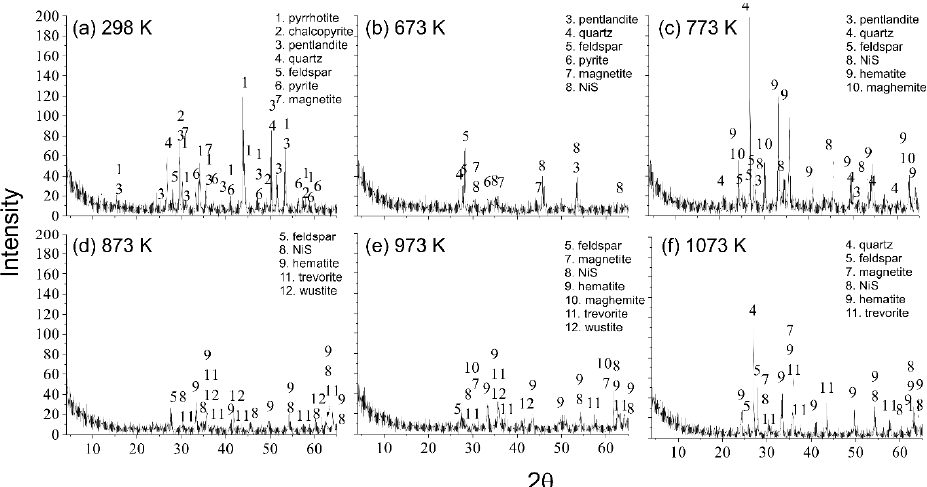
Figure 1. The results of XRD analysis for the ( a ) initial sample, ( b ) oxidation product at 673 K, ( c ) 773 K, ( d ) 873 K, ( e ) 973 K and ( f ) 1073 K.